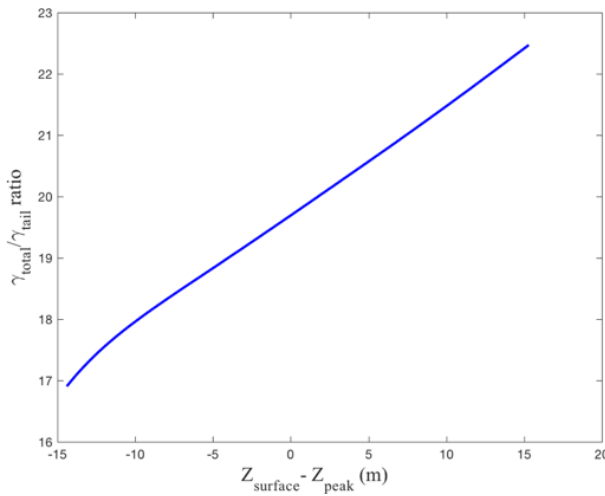
Figure 5. The total-to-tail signal ratio as a function of the eleva- tion difference between the true surface and the downlinked surface sample peak z surface – z peak